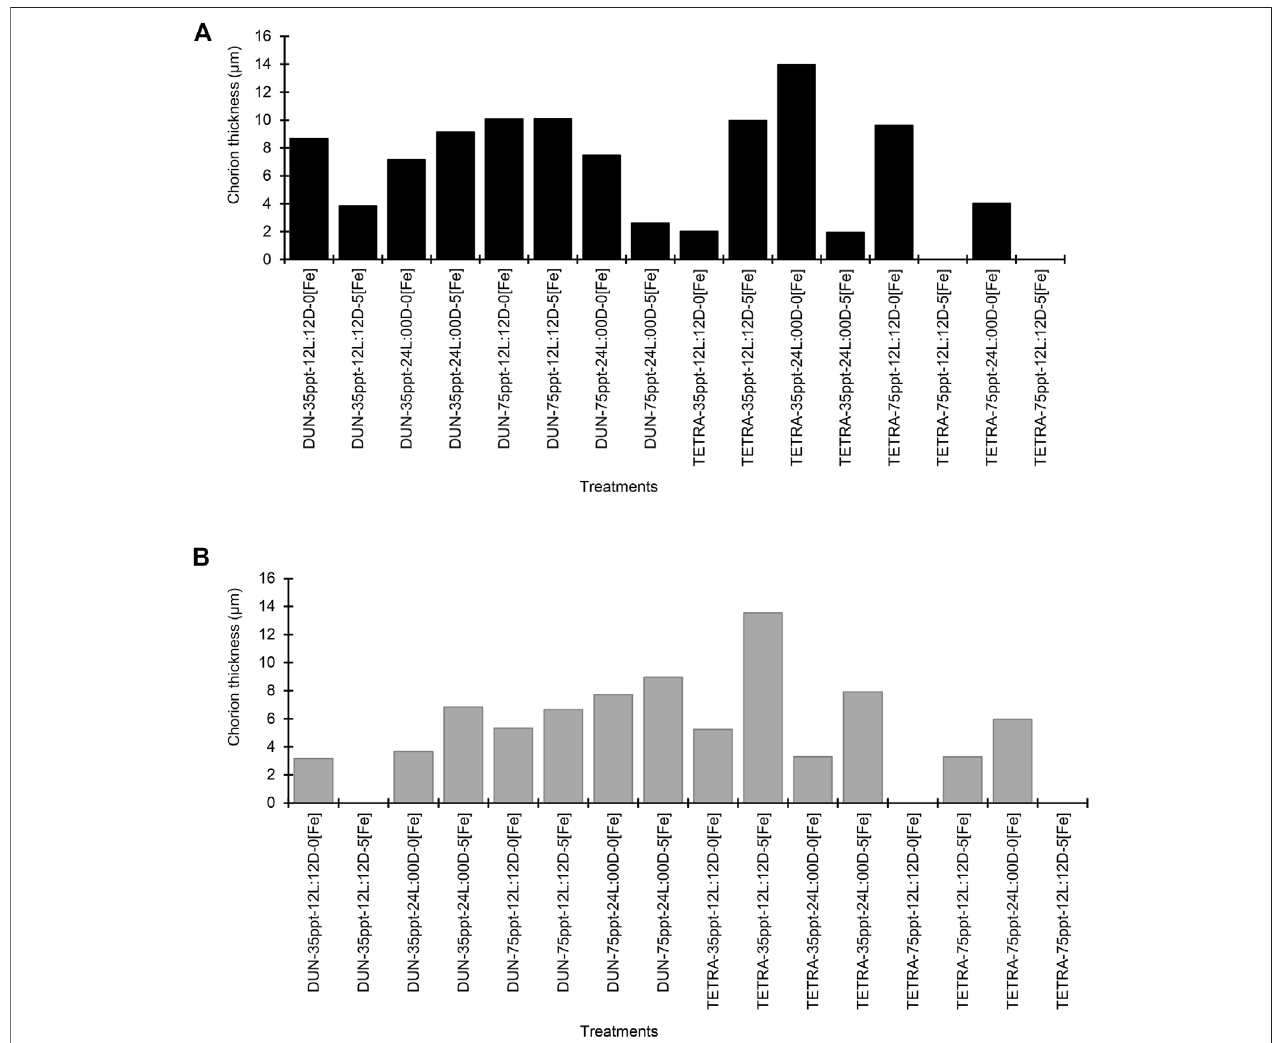
FIGURE 2 | Chorion thickness (µm) in two populations of Artemia franciscana exposed to a combination of different diets, salinity, photoperiod, and iron concentration treatments. (A) Barro Negro population and (B) San Francisco Bay population.